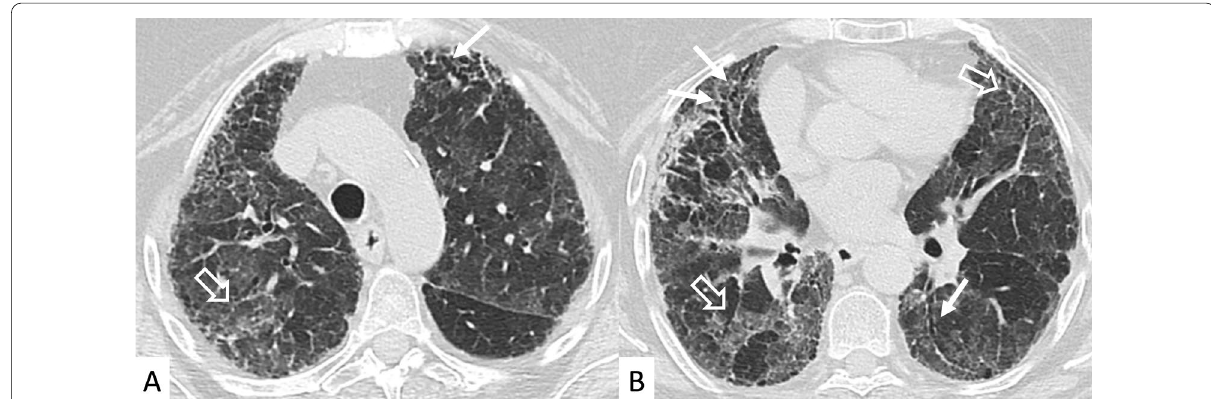
Fig. 2 Axial HRCT images of a patient with rheumatoid arthritis. A , B clearly show ground-glass opacities (empty white arrows) and bronchiectasis (white arrows), resembling an NSIP pattern